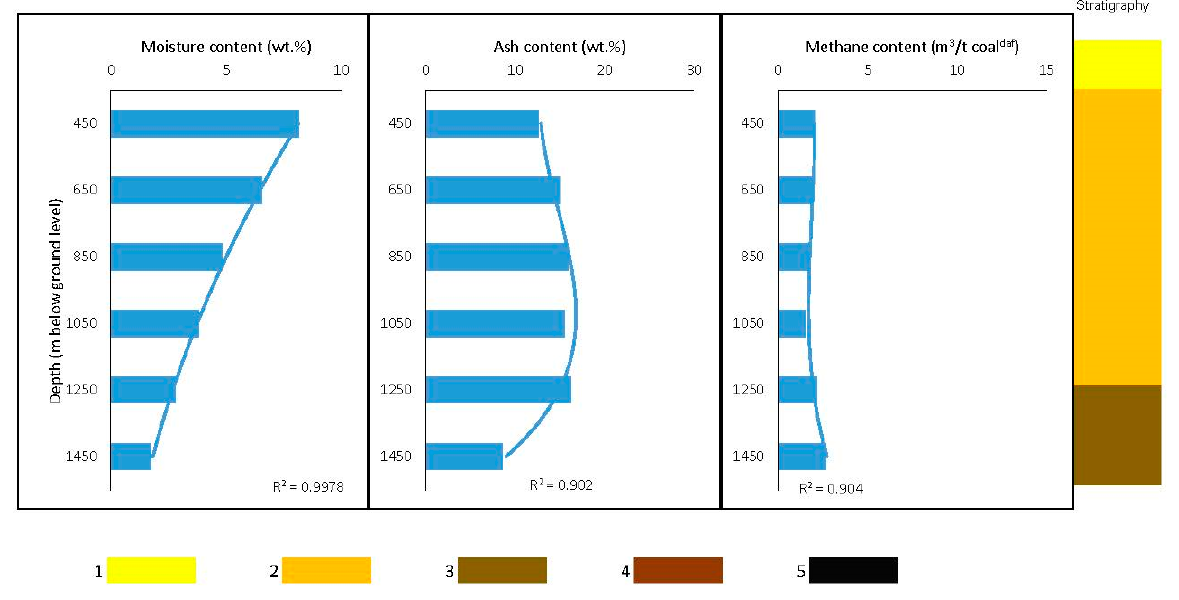
Figure 5. Depth trends of average moisture, ash and methane contents related to stratigraphy in sub-area 1 ( Ć wiklice); 1—Miocene strata, 2—Moscovian Cracow Sandstone Series, 3—Upper Bashkirian Mudstone Series, 4—Lower Bashkirian Upper Silesian Sandstone Series, 5—Serpukhovian Paralic Series.